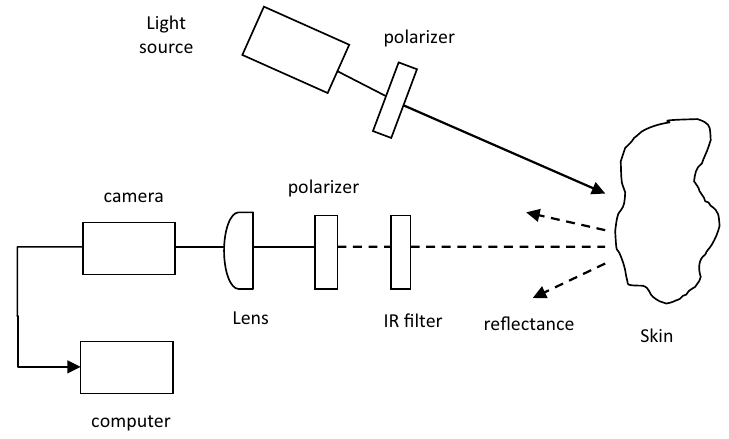
Fig. 1. Schematic diagram of NIR imaging